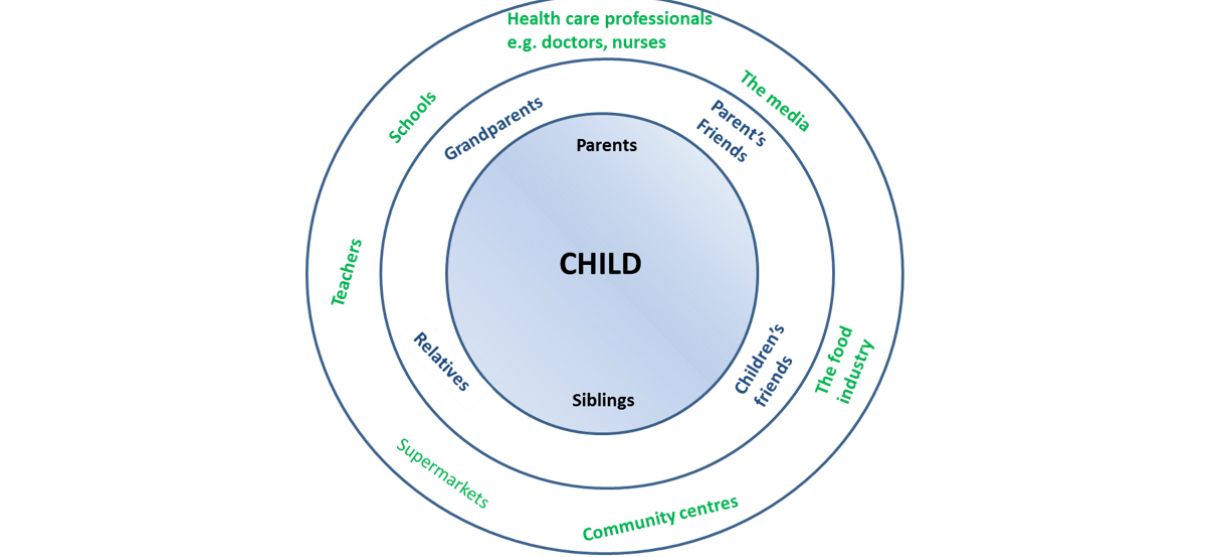
Figure 2. Relevant individuals, groups and populations involved in children's energy